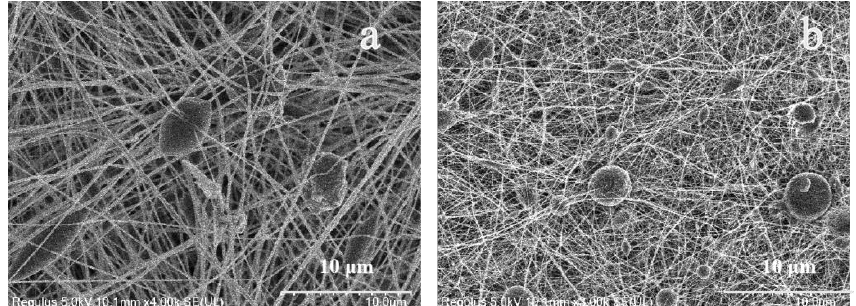
Figure 2. SEM images. ( a ) PVDF electrospun nanofibers under the process condition of 28 °C and 6:4 solvent volume ratio; ( b ) PVDF – AuNPs electrospun nanofibers under the condition of 28 °C and 6:4 solvent volume ratio.